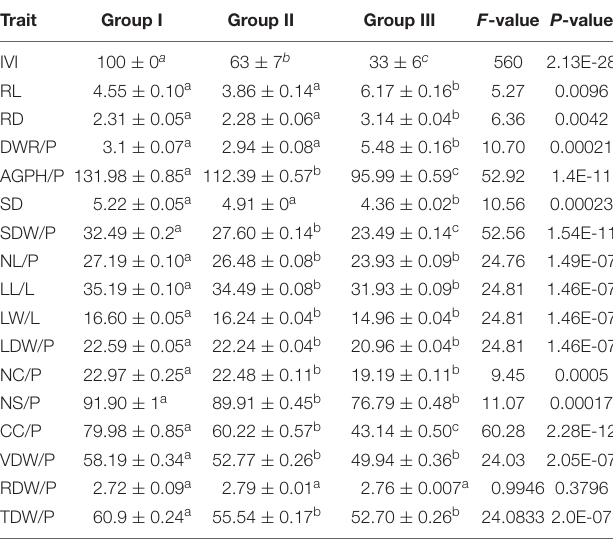
TABLE 1 | Morphological and biomass traits variations represented as mean and SE with ANOVA output of Silybum marianum ( S. marianum ) along the elevation gradient in Pakistan.